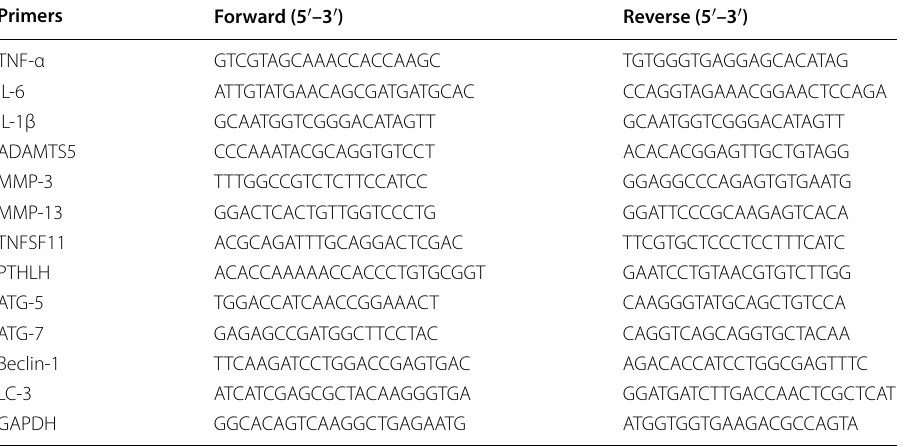
Table1 qPCR primer sequences for target gene Primers Forward (5 ′ –3 ′